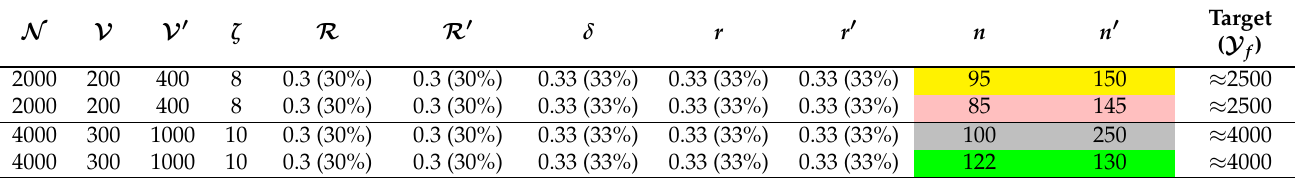
Table 4. Potential realistic